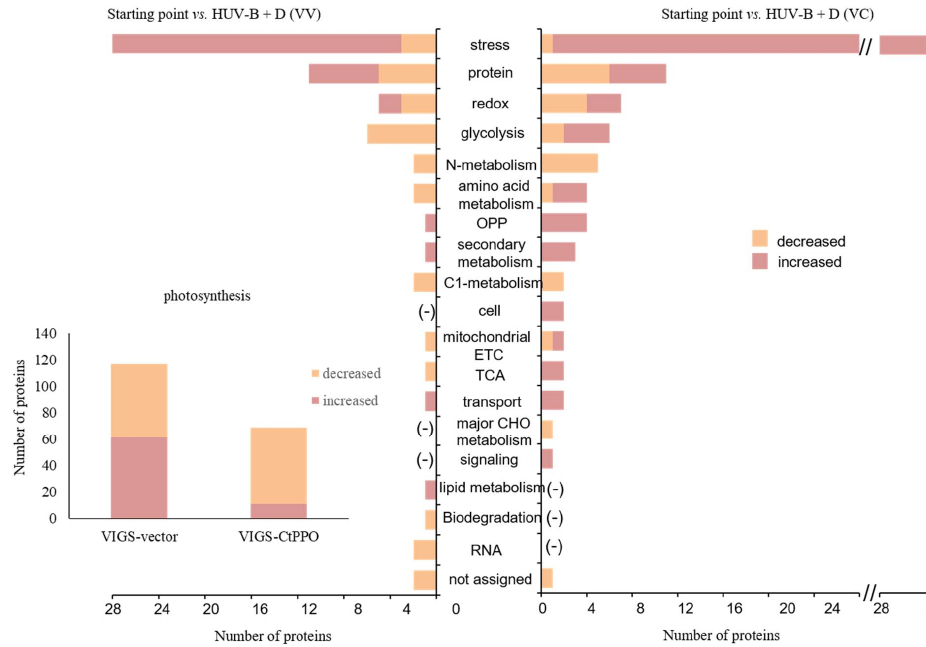
Figure 3. Functional distribution of proteins identified in VIGS-vector and VIGS-CtPPO C. terniflora DC. leaves. Leaves were collected at the starting point and after HUV-B+D treatment. Proteins were extracted, reduced, alkylated, digested, and analyzed by nanoLC-MS/MS. Protein content is reported as mol %. Protein functions were predicted and categorized using MapMan bin codes. Abbreviations: cell, cell division/organization/cycle; TCA, tricarboxylic acid; ETC, electron transport chains; CHO, carbohydrate; OPP, oxidative pentose phosphate; (-), not determined.